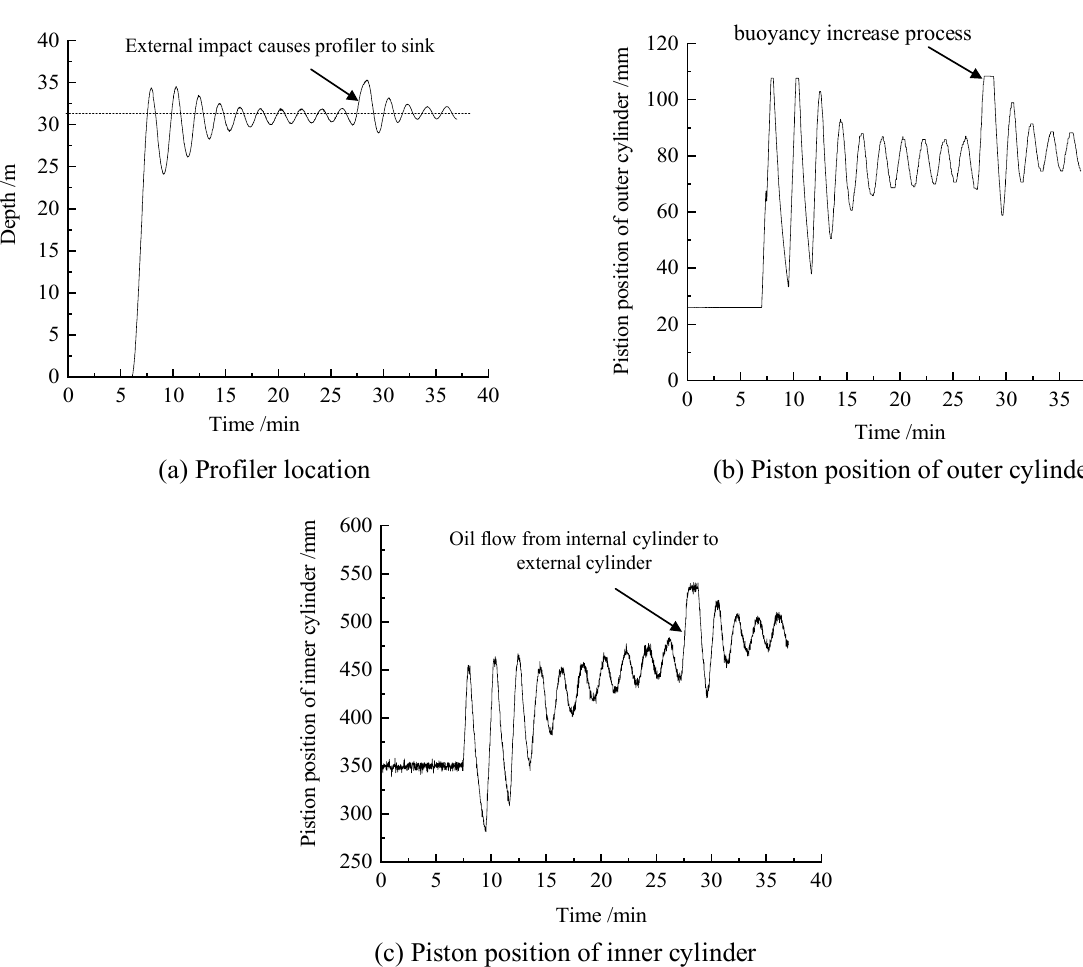
Figure 10. Response curve of the profiler under vertical impact.